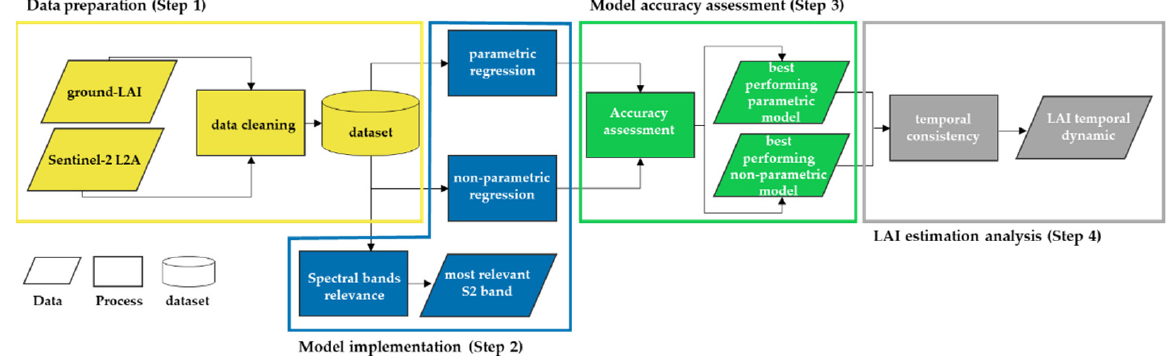
Figure 1. General framework of the work: Step 1 (Yellow boxes) data preparation; Step 2 (Blue boxes) model implementation; Step 3 (Green boxes) model accuracy assessment; and Step 4 (Grey boxes) LAI estimation